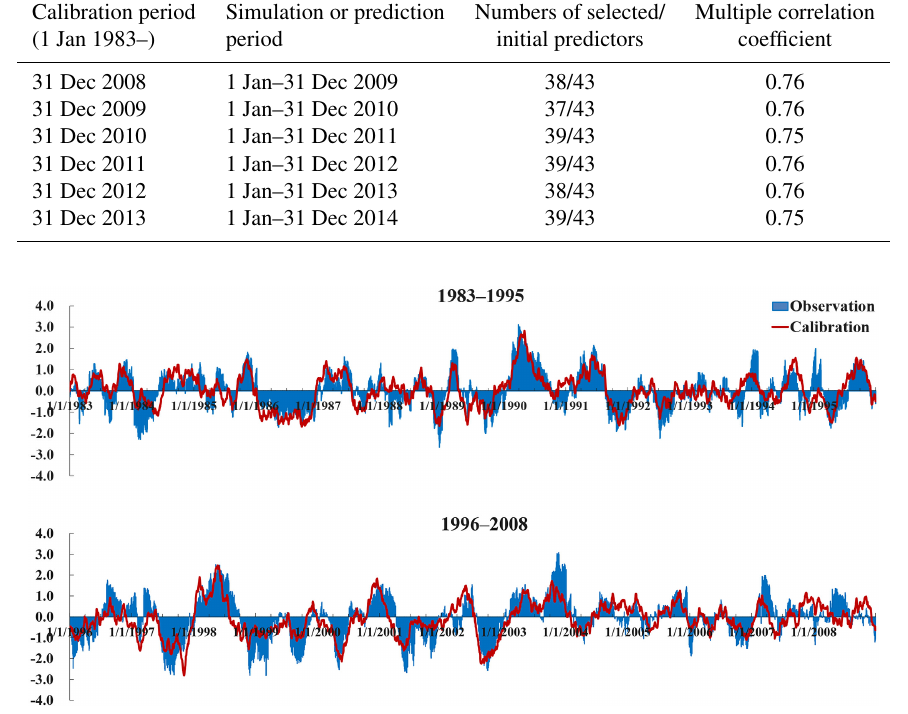
Figure 9. Temporal evolution of observed and calibrated SPI3 during the calibration period between 1 January 1983 and 31 December 2008 in northern